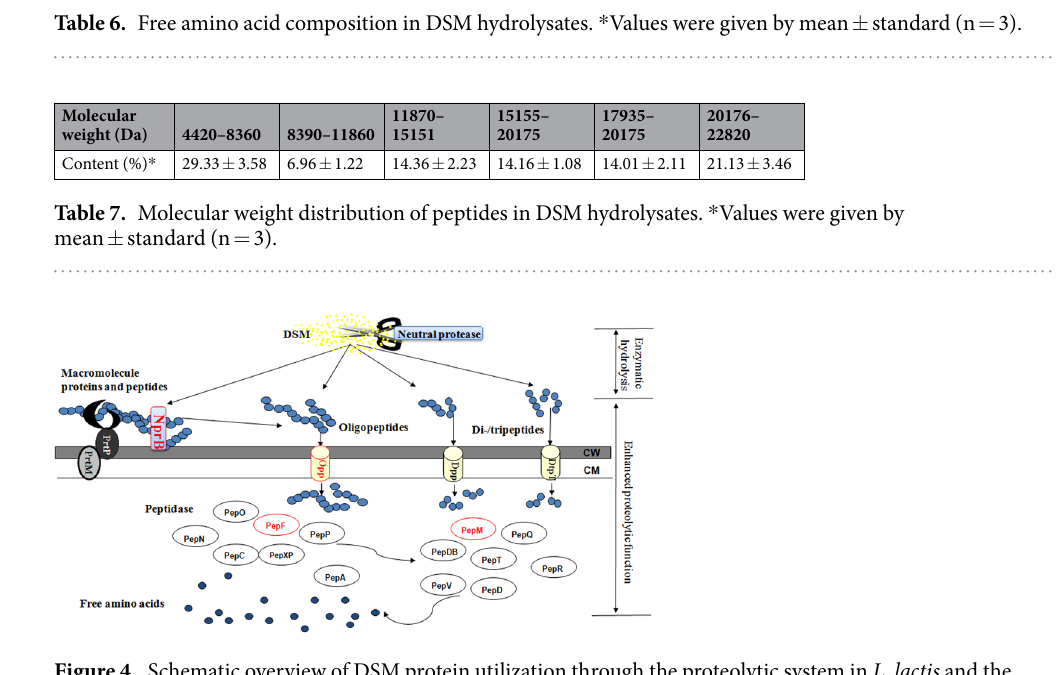
Figure 4. Schematic overview of DSM protein utilization through the proteolytic system in L . lactis and the genes or components with enhanced activity implemented in this study (red symbols). NprB was a heterologous protease from B . subtilis 168. The function of Opp system was enhanced by overexpression of OppA, a membrane lipoprotein. Peptides degradation ability was enhanced by overexpression of two peptidases, PepF and PepM. CW: cell wall. CM: cell membrane. CEP: cell-envelope